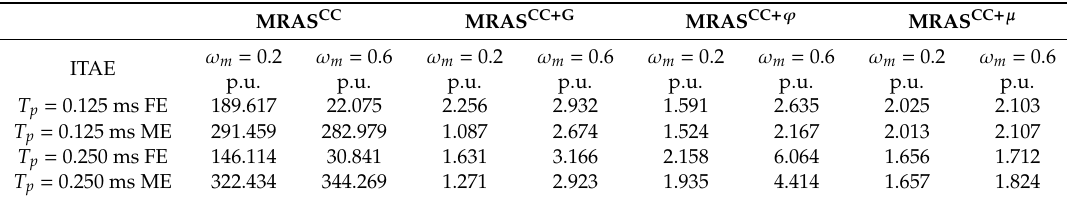
Table 4. ITAE criterion values for ω m = 0.2 p.u. and ω m = 0.6 p.u. speeds under regenerating mode—experimental results for Figure